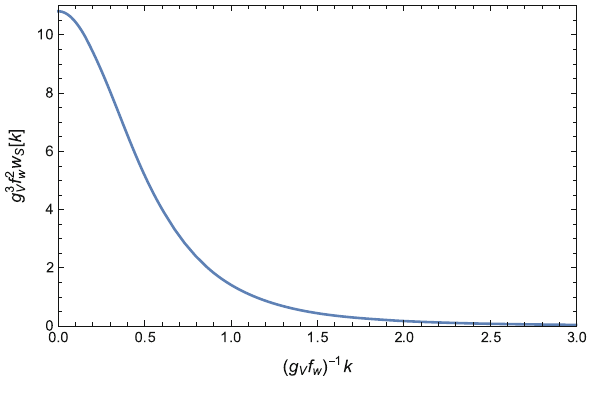
Fig. 3 The skyrmion in k space Fig. 4 The w meson number in the coherent state (31,32)